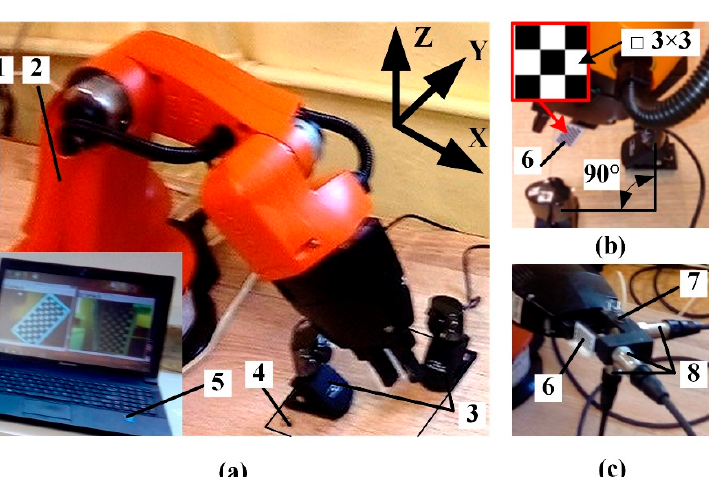
Figure 2. Experimental setup for measurements of positioning accuracy: ( a ) general view; ( b ) position of the cameras; ( c ) accelerometers mounted on robot gripper. 1—base; 2—robot; 3—USB cameras; 4—based on which are mounted cameras; 5—personal computer; 6—optical checkerboard matrix; 7—holder for cameras; 8—accelerometers.